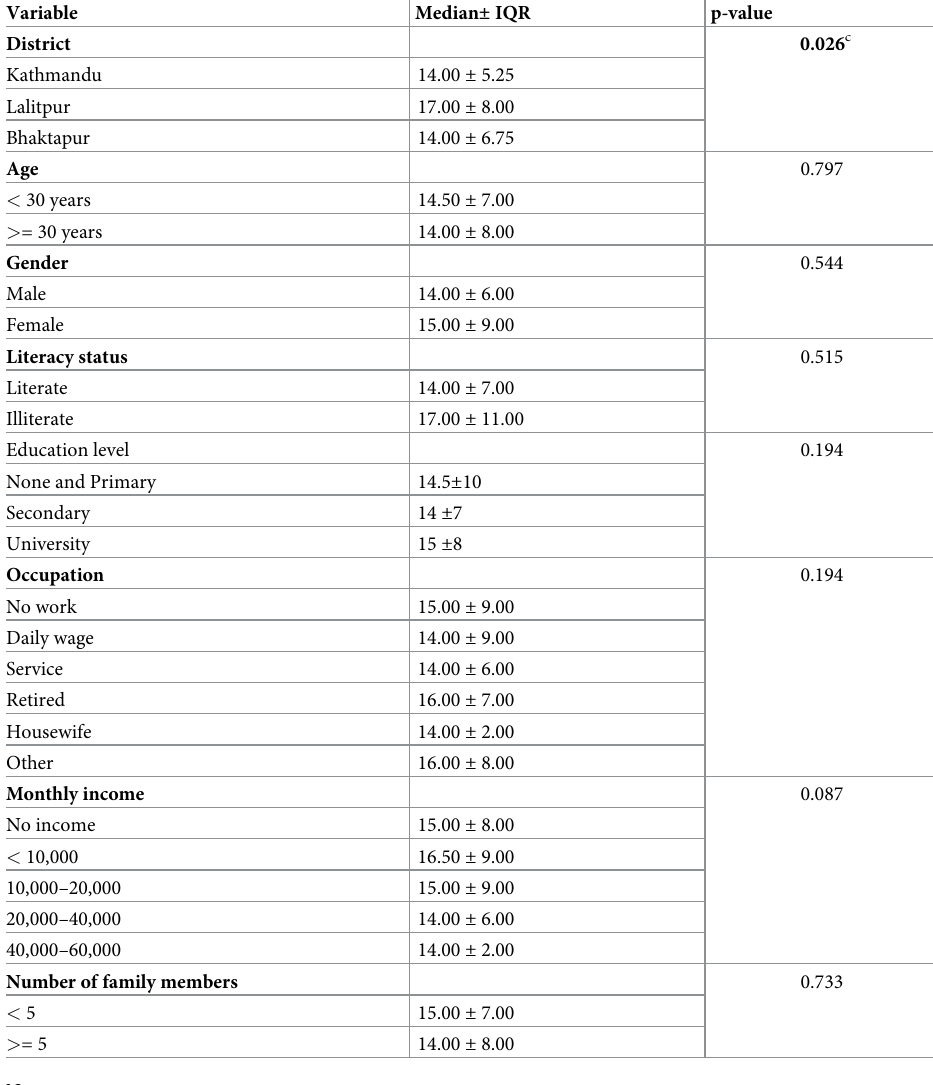
Table 5. Comparison of attitude scores among different subgroups of